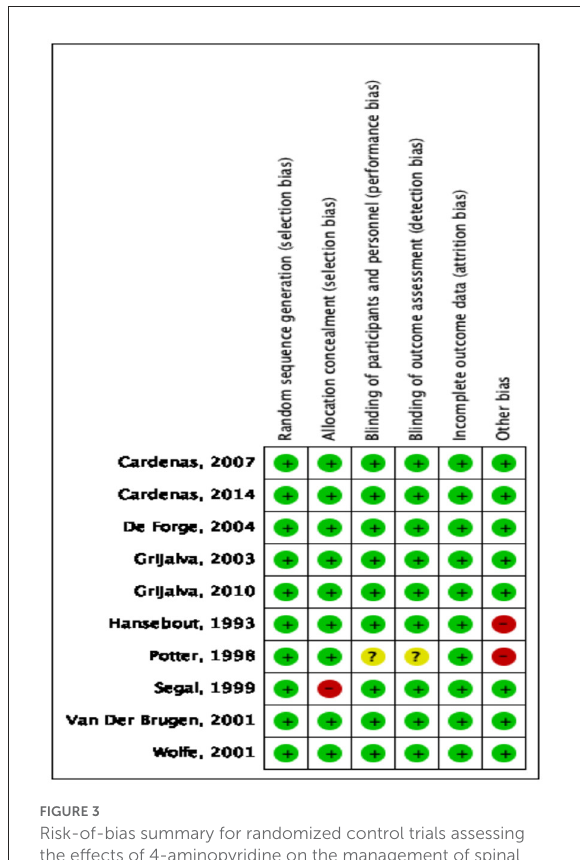
FIGURE3 Risk-of-bias summary for randomized control trials assessing the effects of 4-aminopyridine on the management of spinal cord